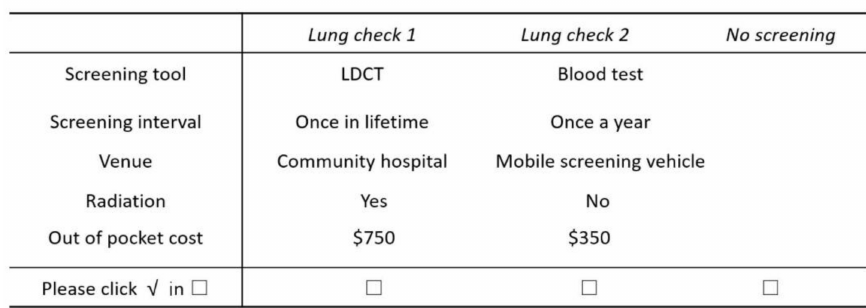
Figure 1. An example choice